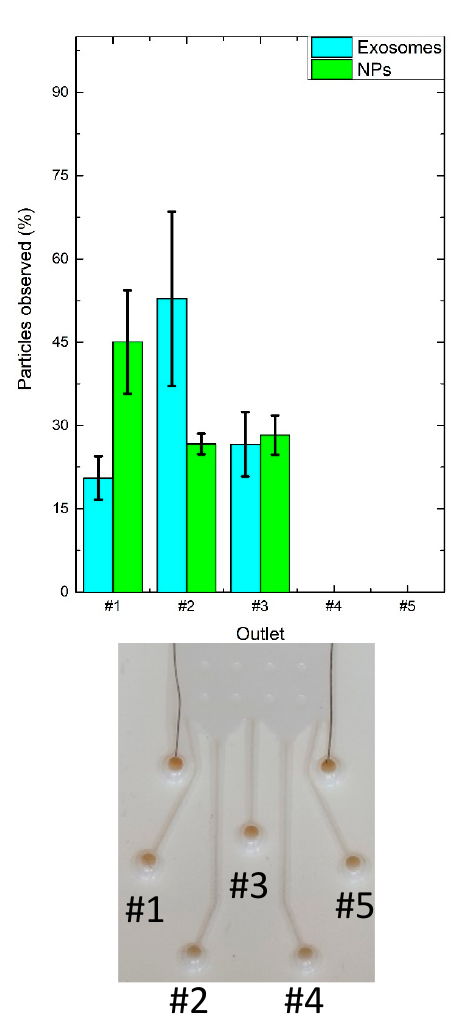
Figure 9. EX and NP collections at the outlets of the glossy µFFE device by setting a buffer flow rate of 20 µL/min and an analyte flow rate of 10 µL/min for 10 min when Δ V = 30 V were applied at the electrodes.